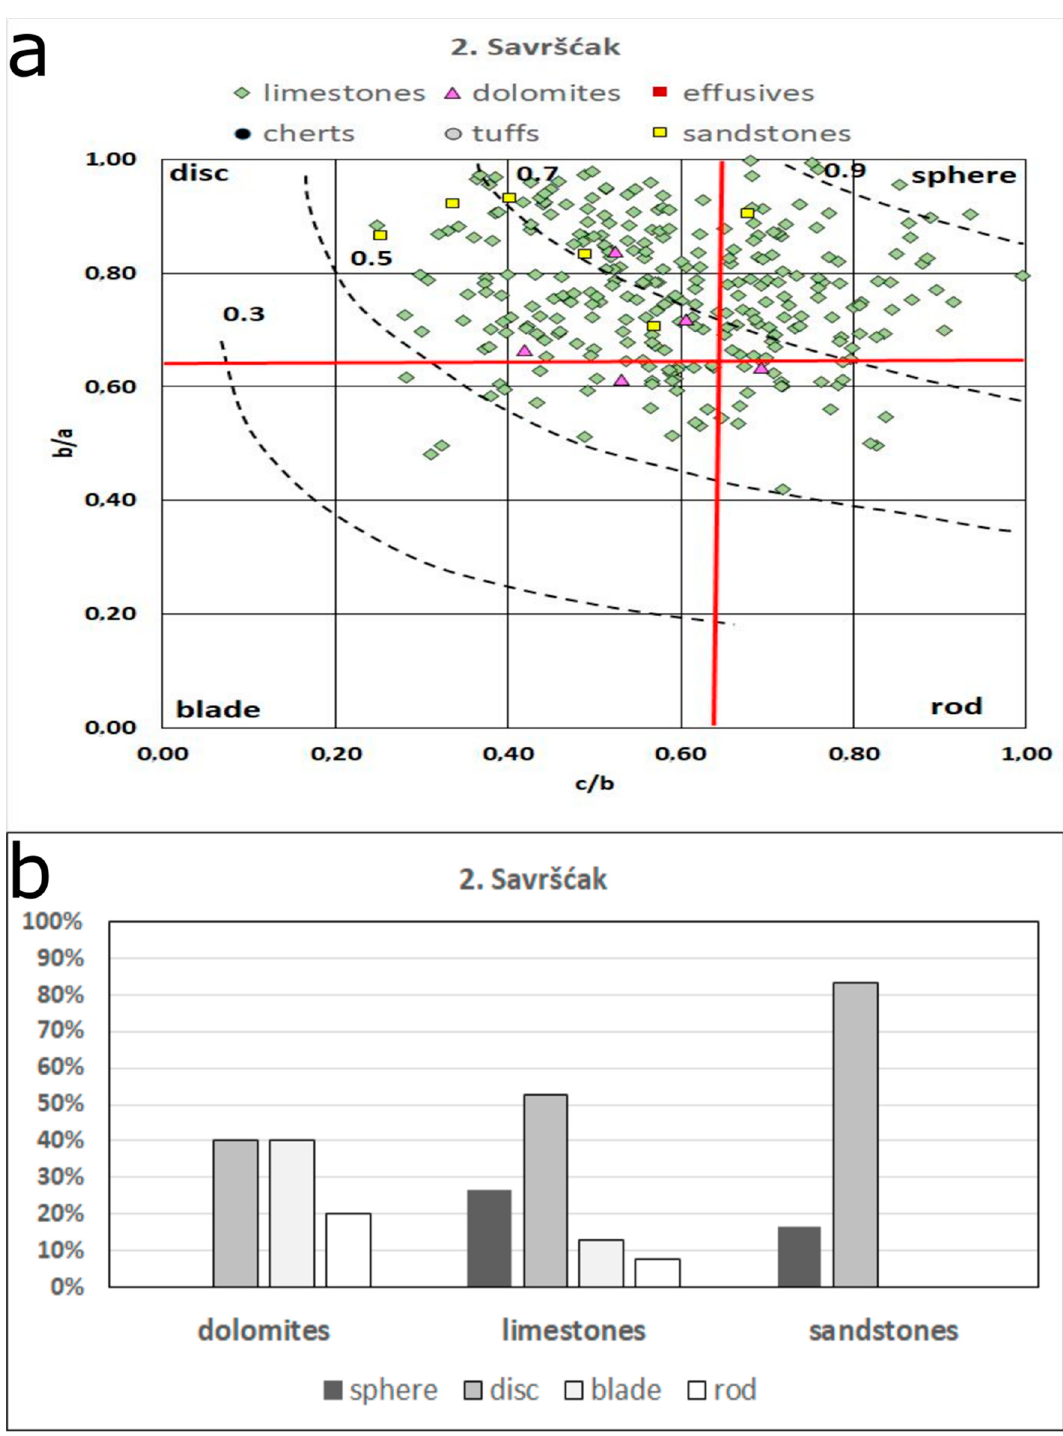
Figure 8. Pebble shapes of main lithotypes in Savrš ć ak: ( a ) Zingg diagram; ( b ) histograms.